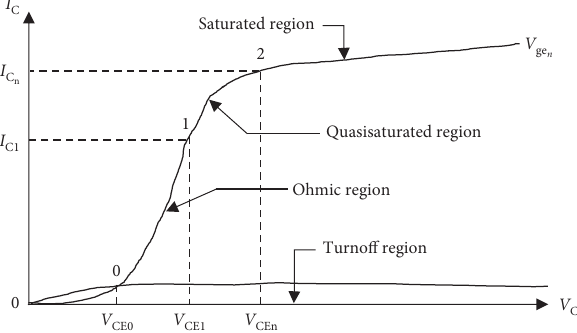
Figure 4: Decomposition of the static